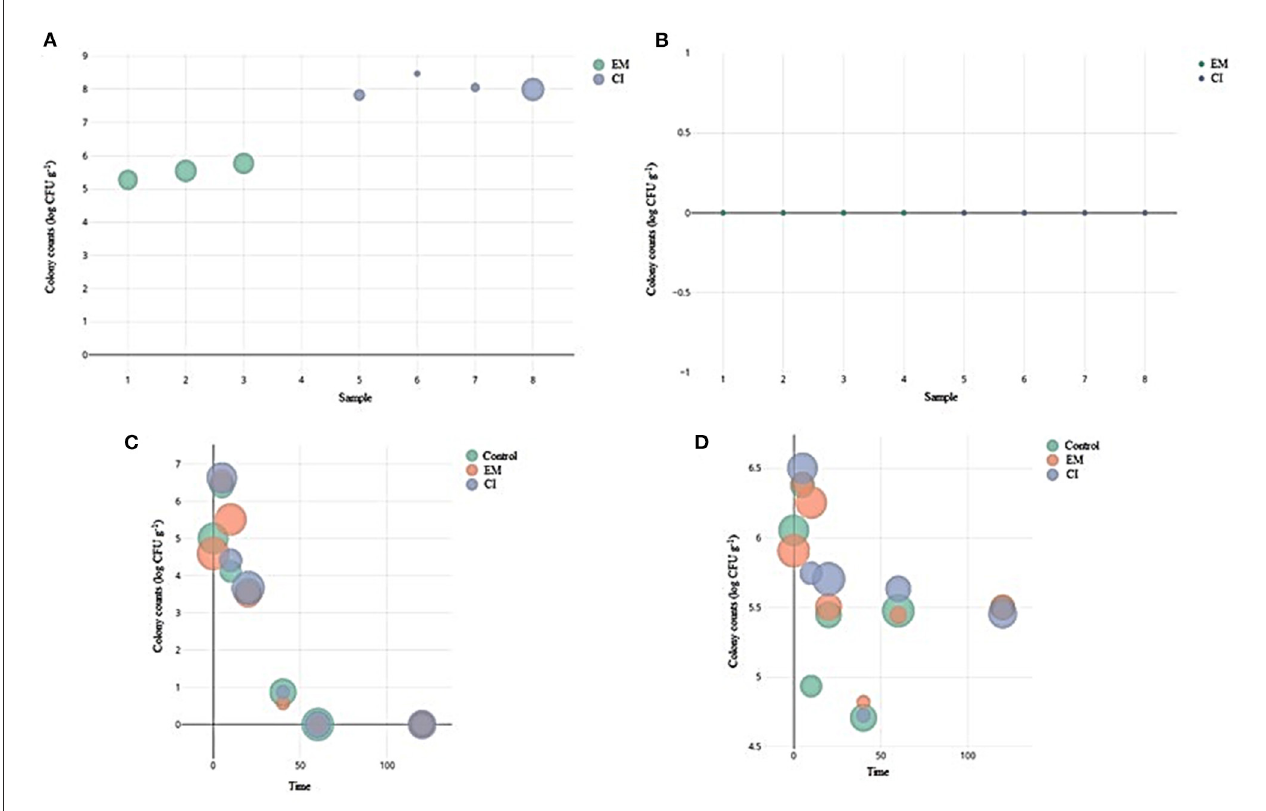
FIGURE1 Colony counts (log CFU g − 1 ) and relative abundance [(counts of isolates/total counts of groups) × 100] of the isolates present in each treatment throughout the composting process. Bubble sizes (diameters) represent relative abundance (%); a bubble representing the maximum abundance is included as a reference. Each chart shows the isolated population from each inoculum and the groups of microorganisms analyzed in each treatment throughout the composting process. (A) Yeast population in the inoculum; (B) Filamentous fungi population in the inoculum; (C) Yeast for the composting process; (D) Filamentous fungi for the composting